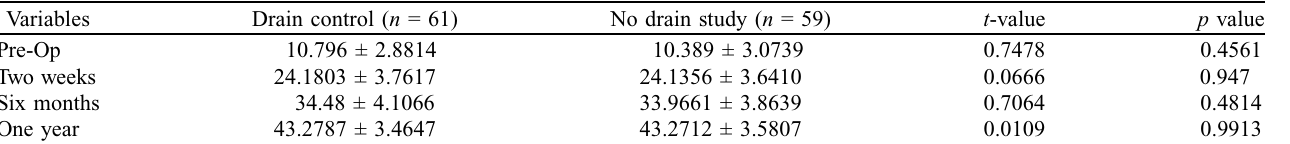
Table 3. Oxford knee scoring